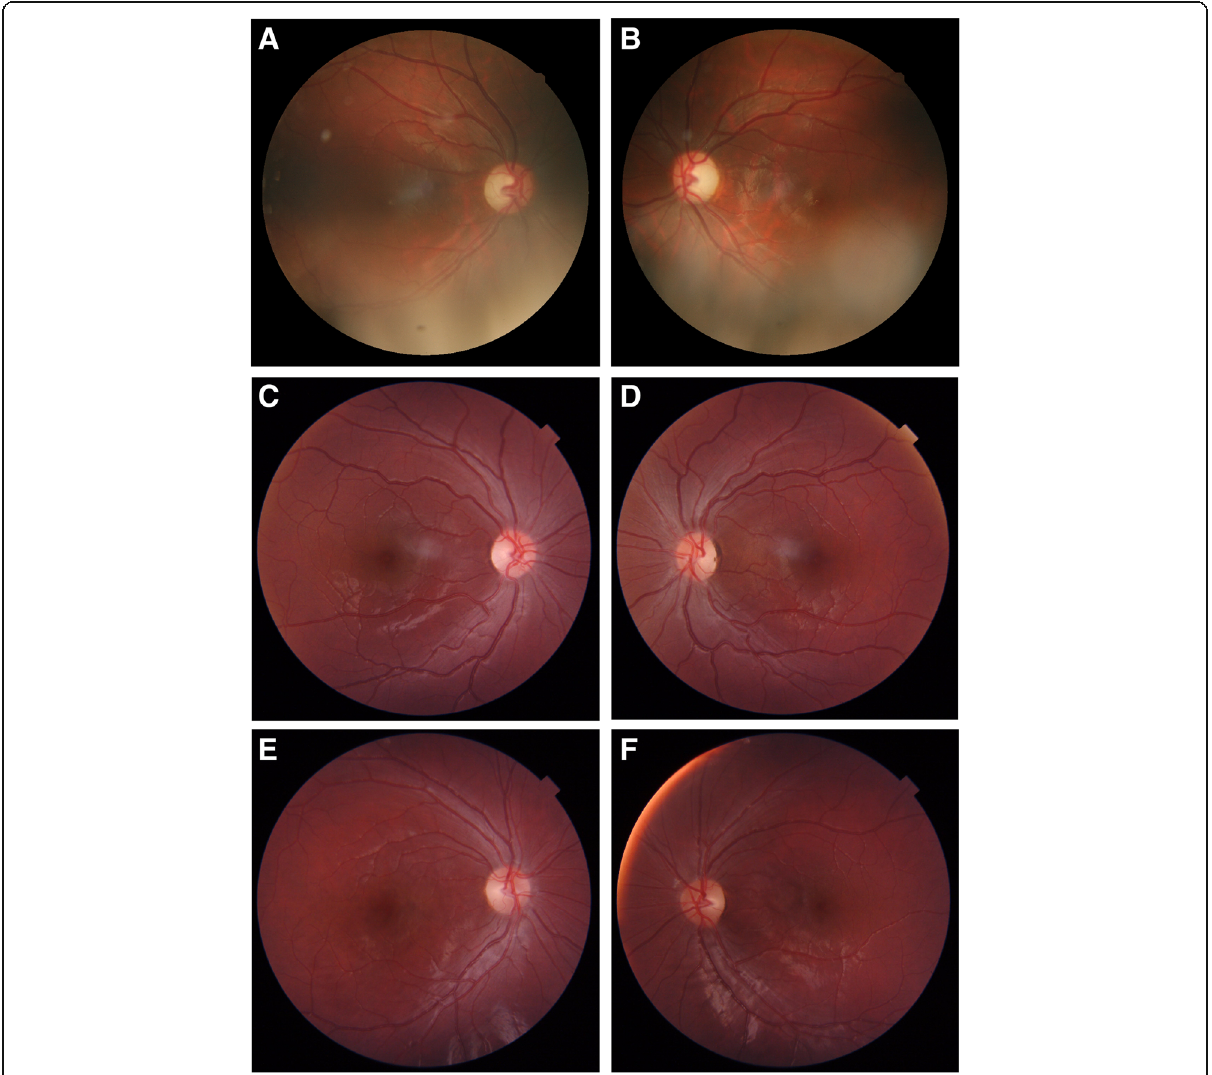
Fig. 2 Eye fundi. Temporal pallor of discs is seen in the right eye ( a ) and the left eye ( b ) of the affected proband in family A (II:1) as well as in the affected sister ( c + d ; II:1) and her brother ( e + f ; II:2) of family